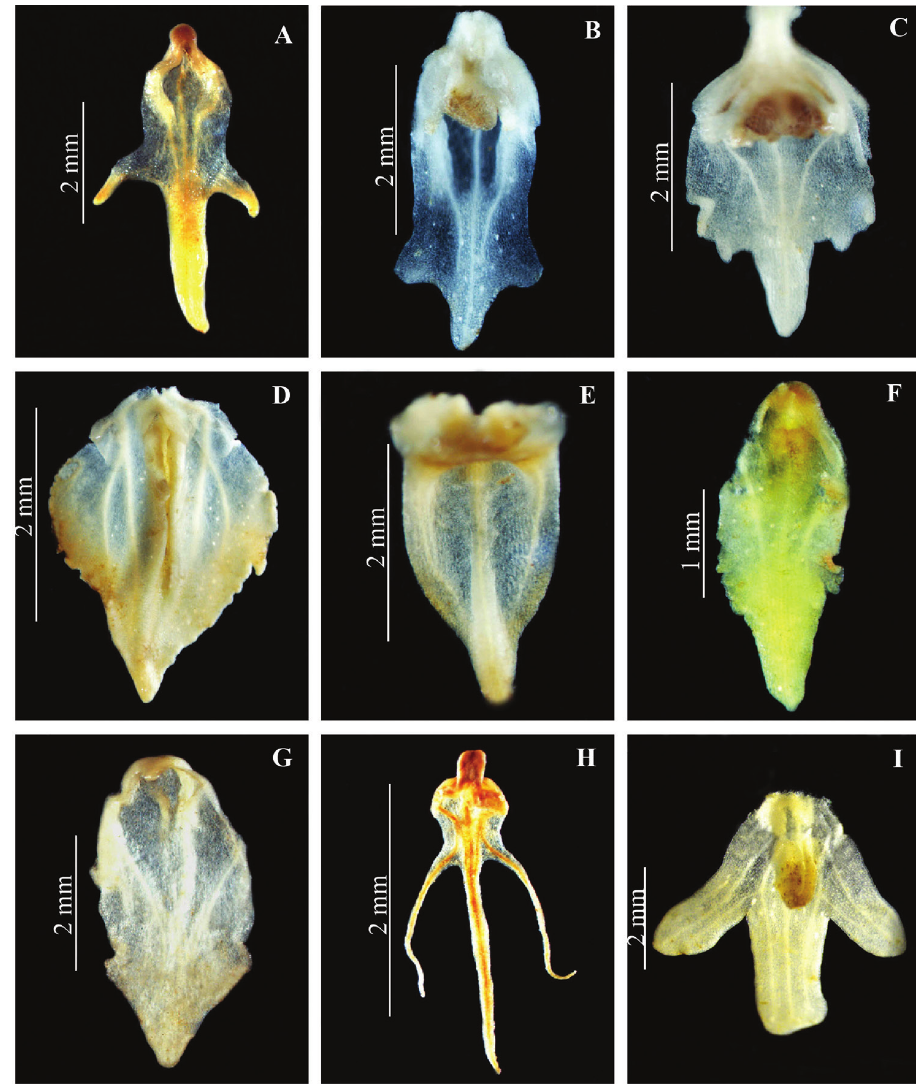
Figure 9. Lip of Herminium . A H. monorchis B H. chloranthum C H. pygmaeum D H. josephi E H. monophyllum F H. macrophyllum G H. macrophyllum H H. alaschanicum I H. coeloceras .